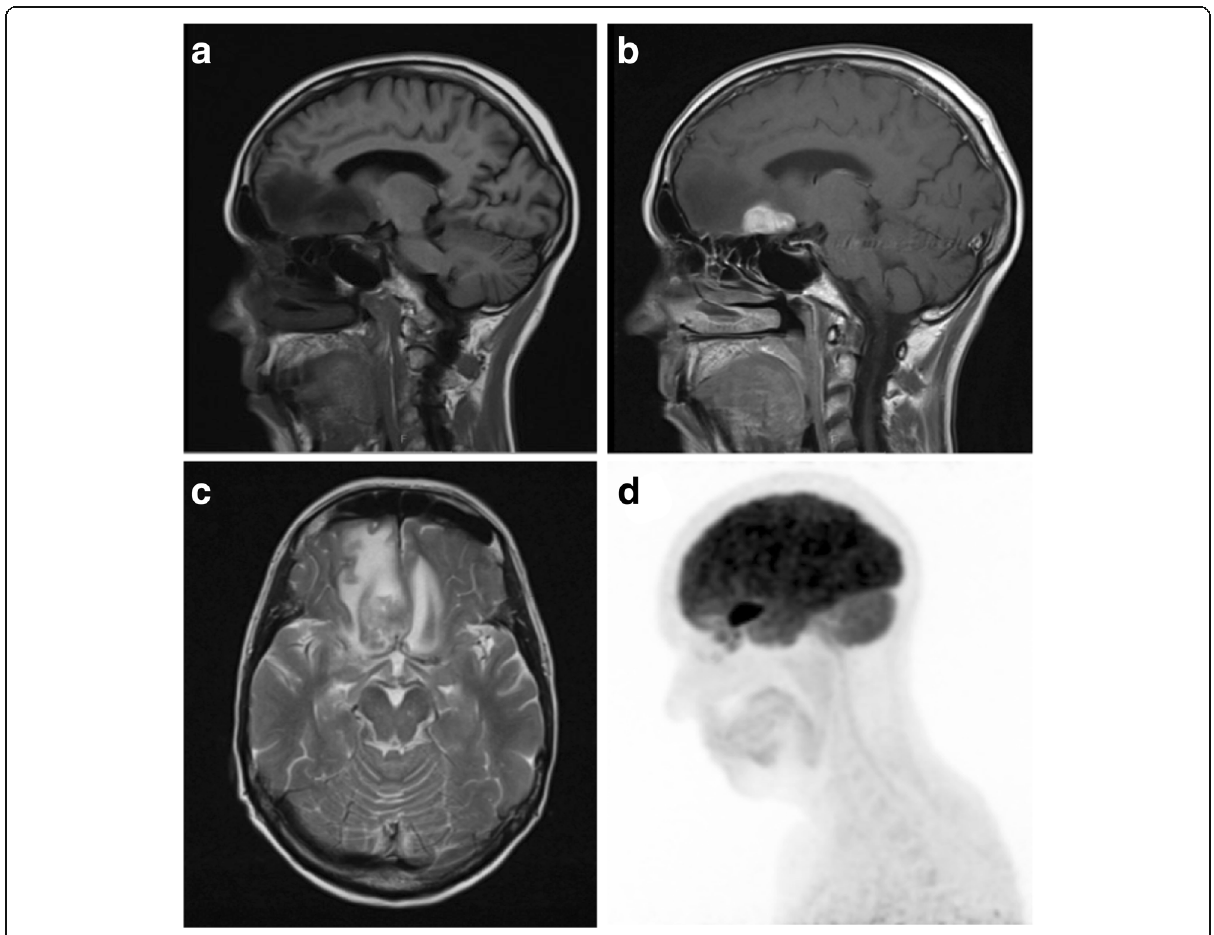
Fig. 8 Lymphomatous deposit. a , b Pre- and post-contrast sagittal T1-weighted MR images showing a solitary extra-axial lymphomatous deposit with a wide dural base and avid enhancement. It is lobulated, and its border is ‘ fluffy ’ and less distinct than that of the typical meningioma. There was no skull hyperostosis or intratumoural calcification on CT imaging. c Axial T2-weighted MR image of the same lesion showing marked vasogenic oedema. d Maximum intensity projected FDG PET image demonstrates avid tracer uptake within the